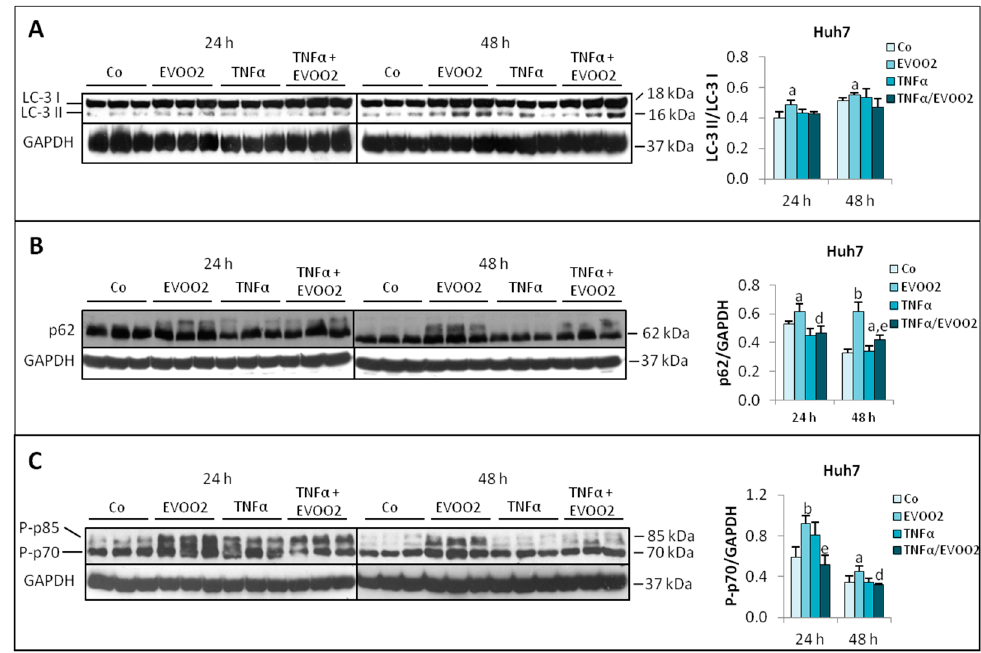
Figure 12. The combined treatment of EVOO extract and TNF α modulates protein turnover in Huh7 cells. ( A–C ) Expression of LC-3 ( A ), p62 ( B ) and P-p70 ( C ) in Huh7 cell lines incubated for 24 and 48 h with EVOO2 phenolic extract in the presence or absence of TNF α . The results are representative of three experiments. The protein molecular weights are reported. Data are presented as mean ± SD. (a: p < 0.05, b: p < 0.01 versus Control; d: p < 0.05, e: p < 0.01 versus EVOO).